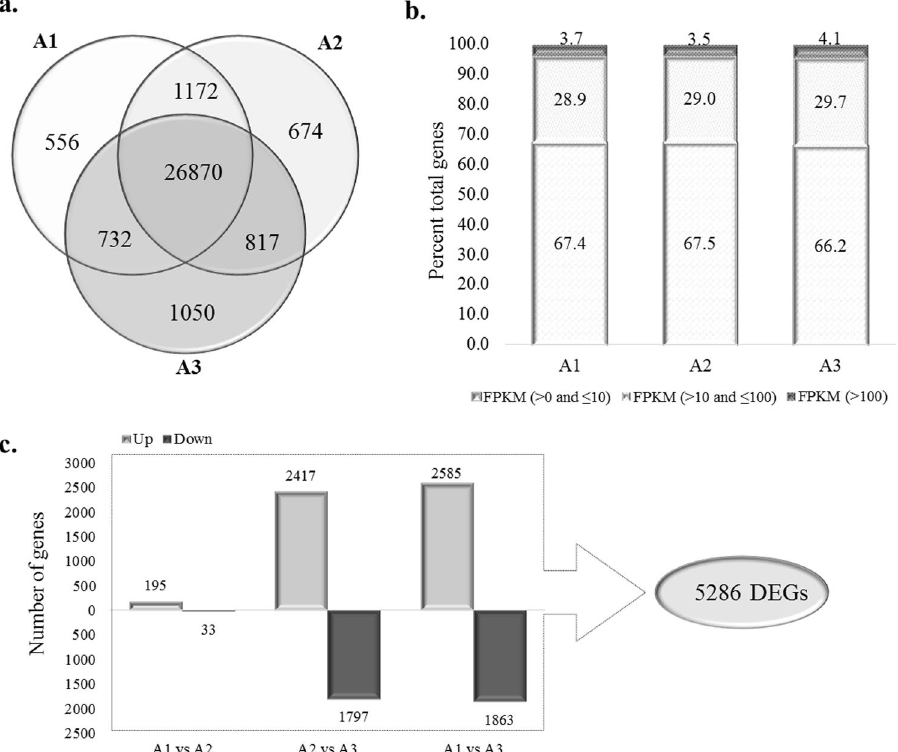
Figure 2. Expression dynamics of sorghum anthers. ( a ) Venn diagram showing overlap between expressed genes in all three stages; ( b ) Distribution of FPKM range in all three stages of anther development and ( c ) Results of differential expression